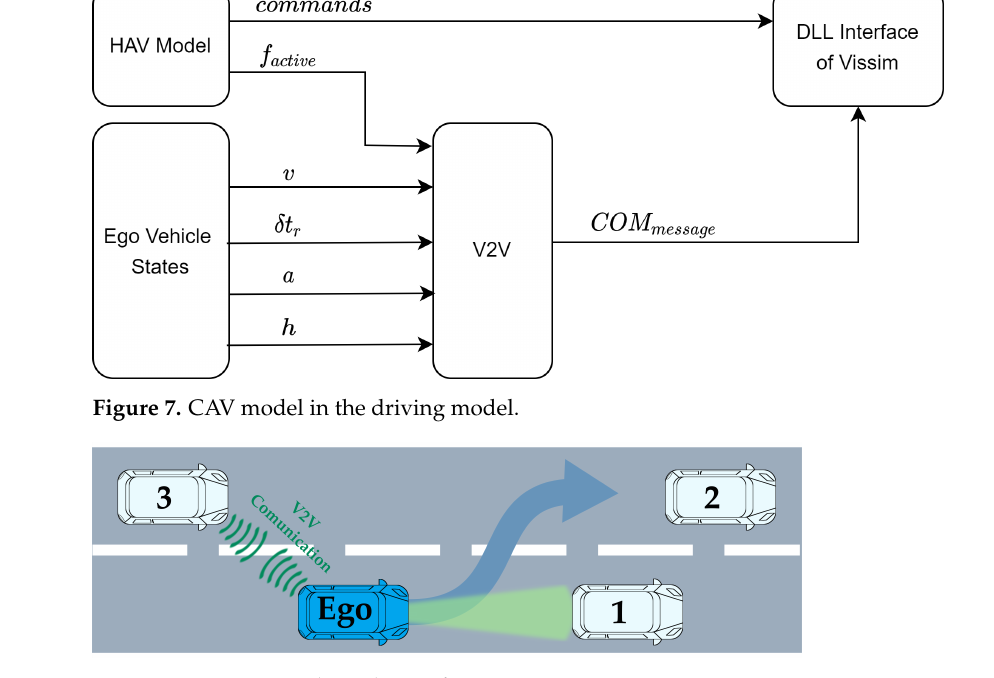
Figure 8. Cooperative lane change for